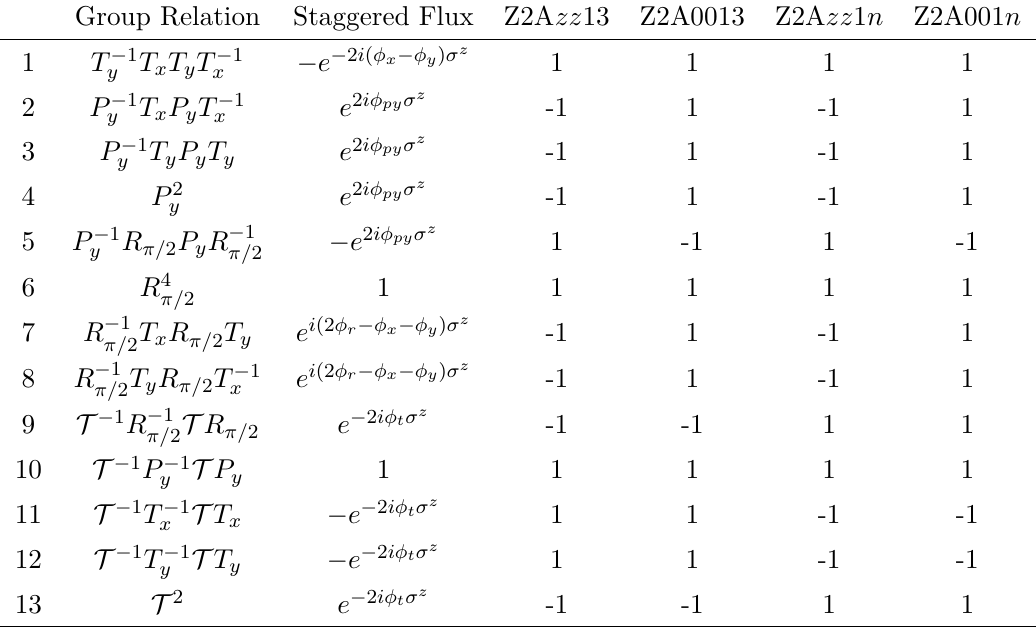
Table 2 . Symmetry fractionalization of the translationally-invariant Z 2 spin liquids proximate to the staggered flux